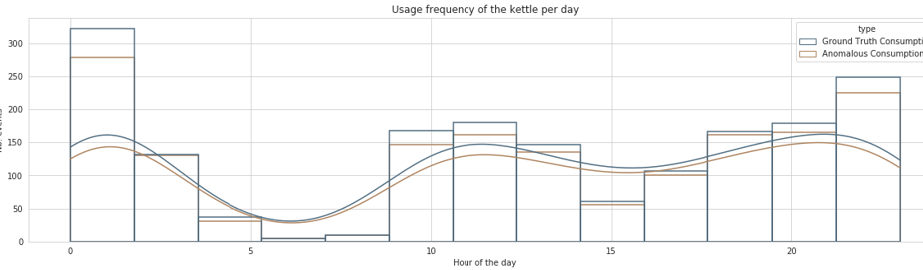
Figure 6. The daily consumption profile of house